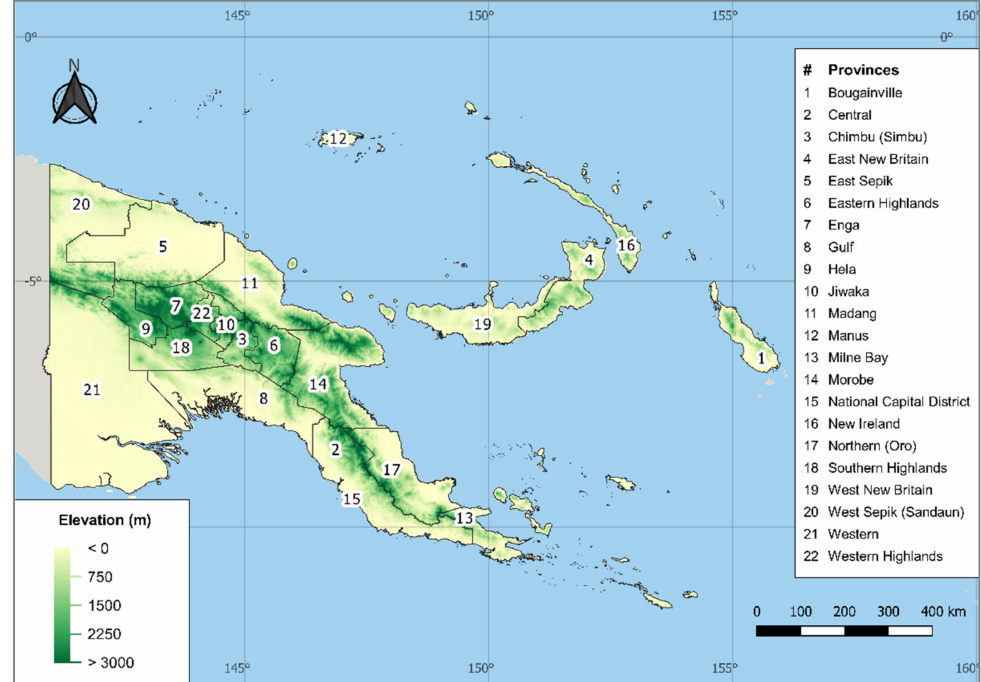
Figure 1. Topographical map of the study area with the 22 provinces of PNG displayed using a numbered